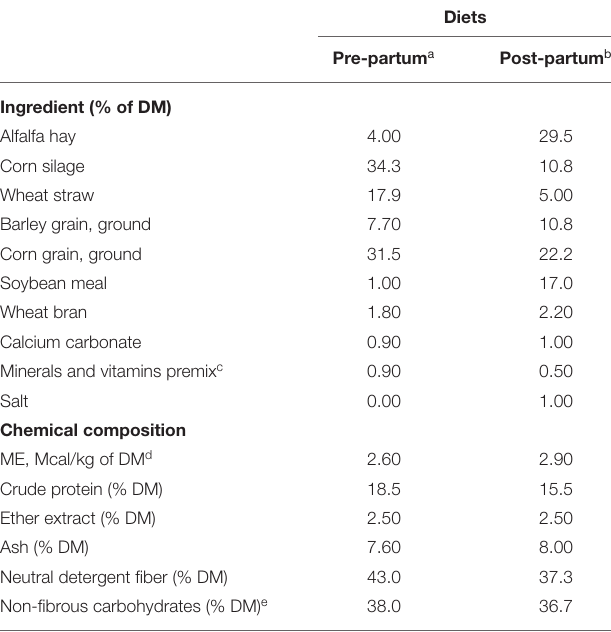
TABLE 1 | Ingredients and nutrient composition (DM basis) of pre- and post-partum